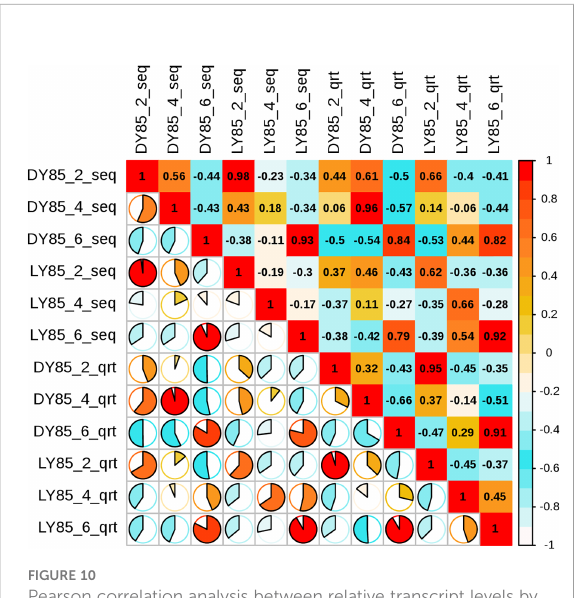
FIGURE 10 Pearson correlation analysis between relative transcript levels by qRT-PCR and transcriptome expression levels by FPKM